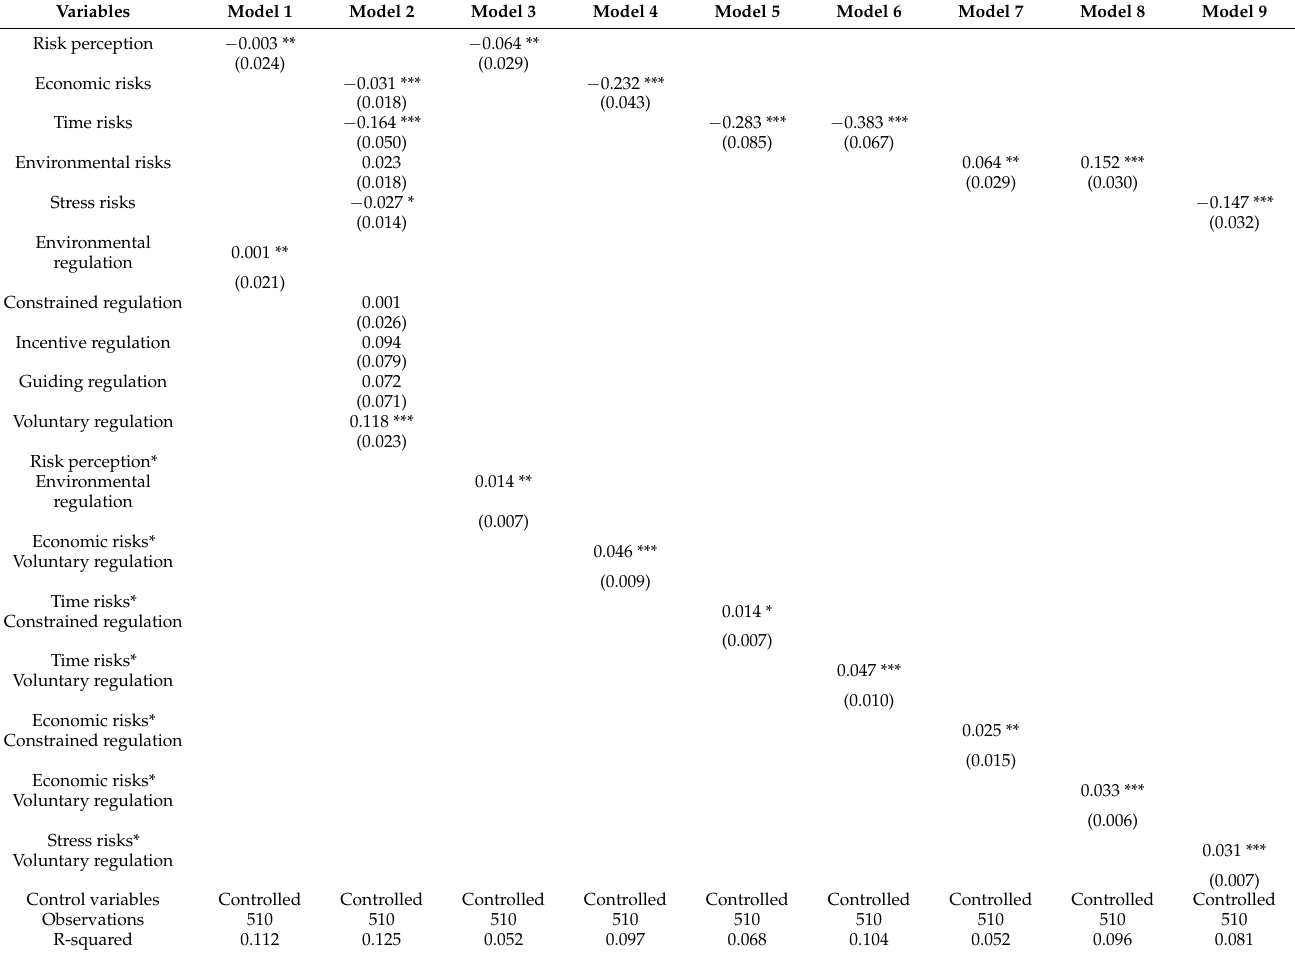
Table 6. Robustness test results ( n =